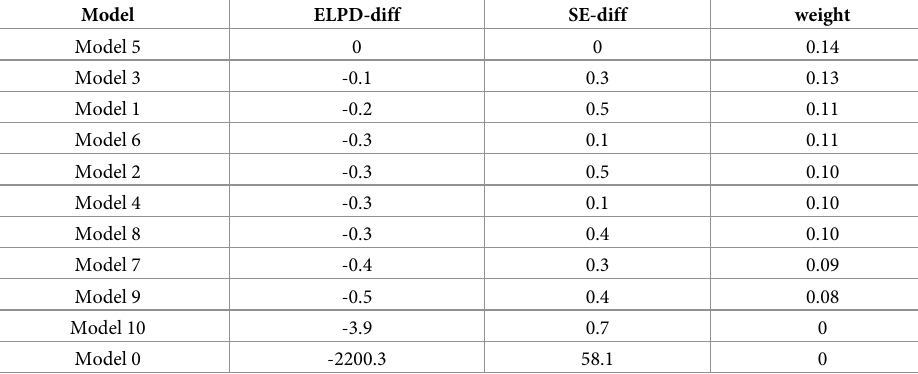
Table 3. Model comparison via leave-one-out